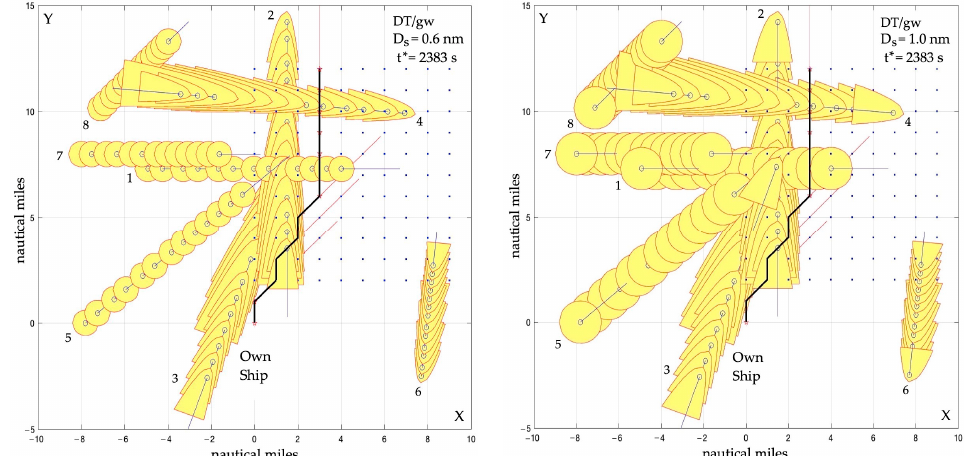
Figure 12. Safe dynamic trajectory of one’s own ship determined by the DT algorithm with neural domains of passing ships in the forms of circles, hexagons, ellipses, and parabolas under conditions of good visibility at sea at different values of the adopted safe passing distance D s ; t* is the optimal time to avoid a collision situation.